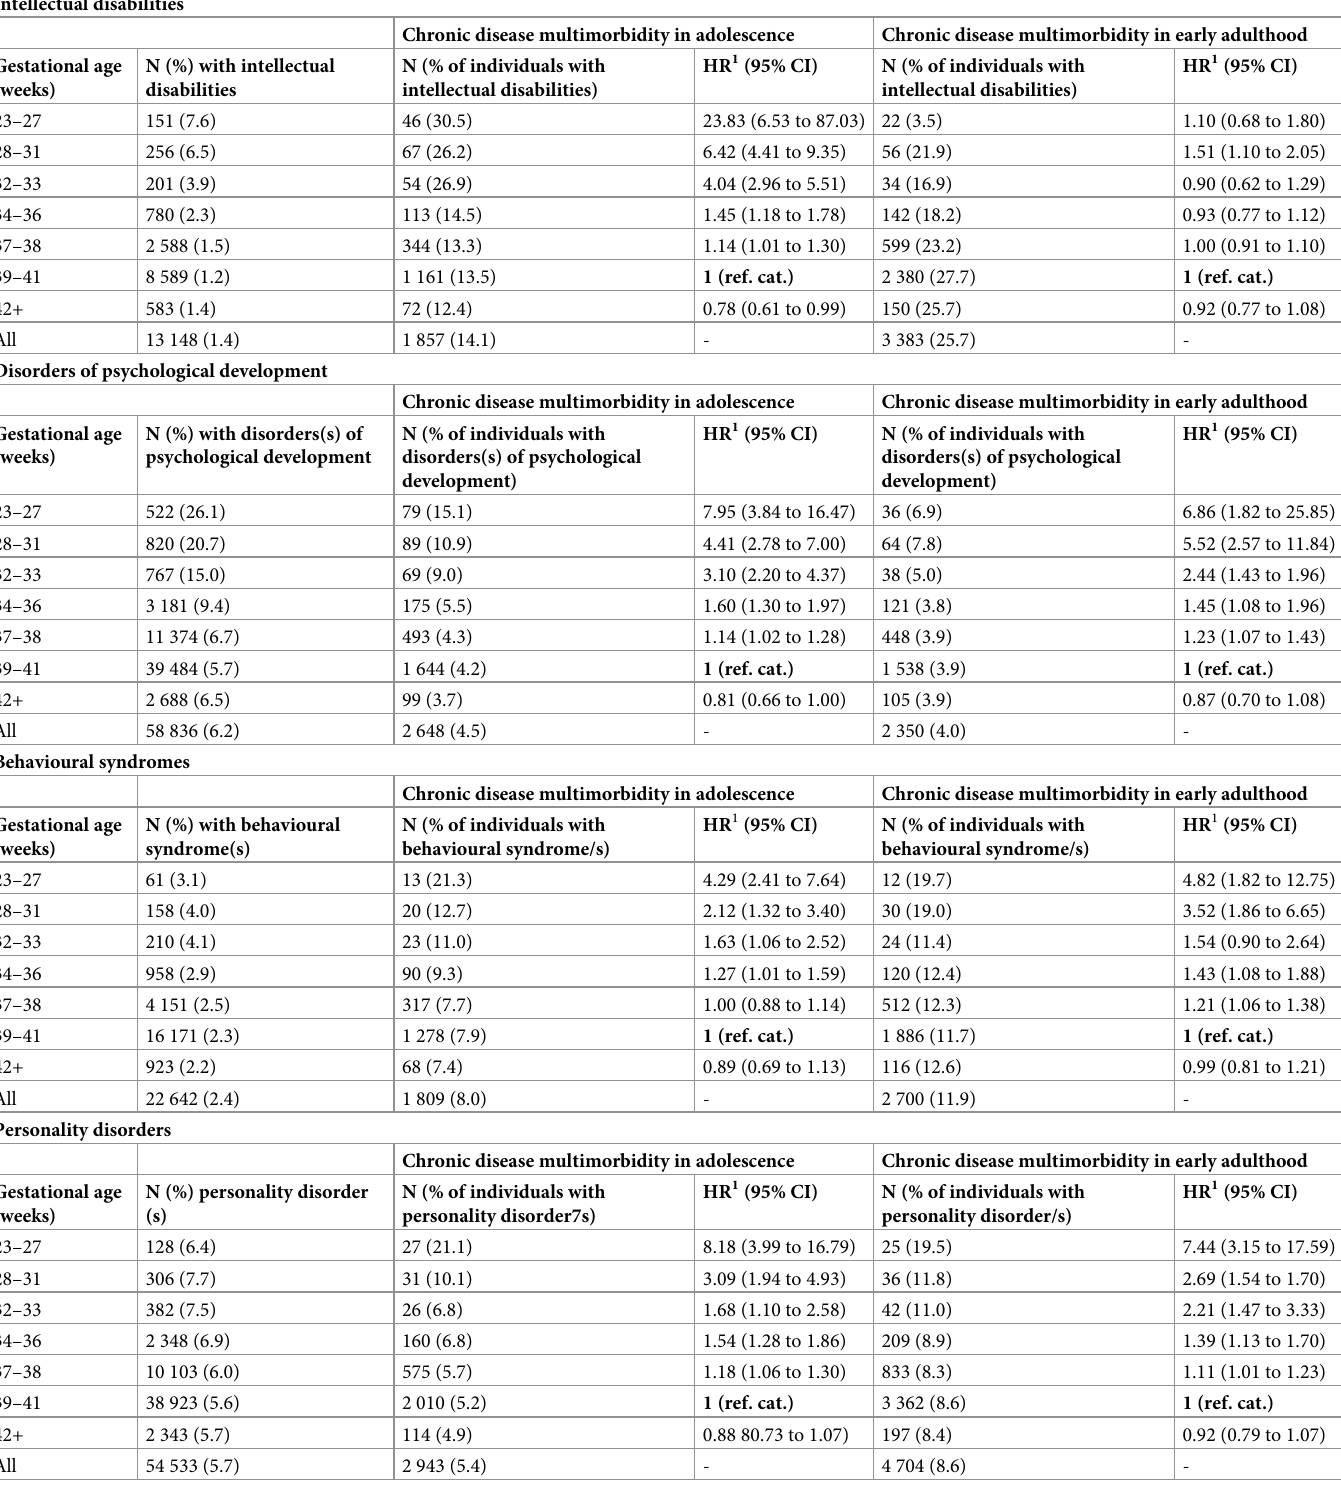
Table 4. Co-occurrence of developmental disorders and chronic disease